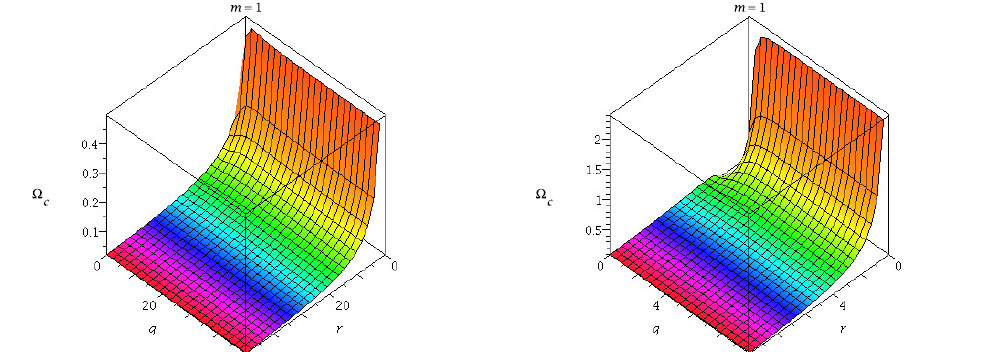
Figure 11. The figure shows the variation of Ω c with r c and q